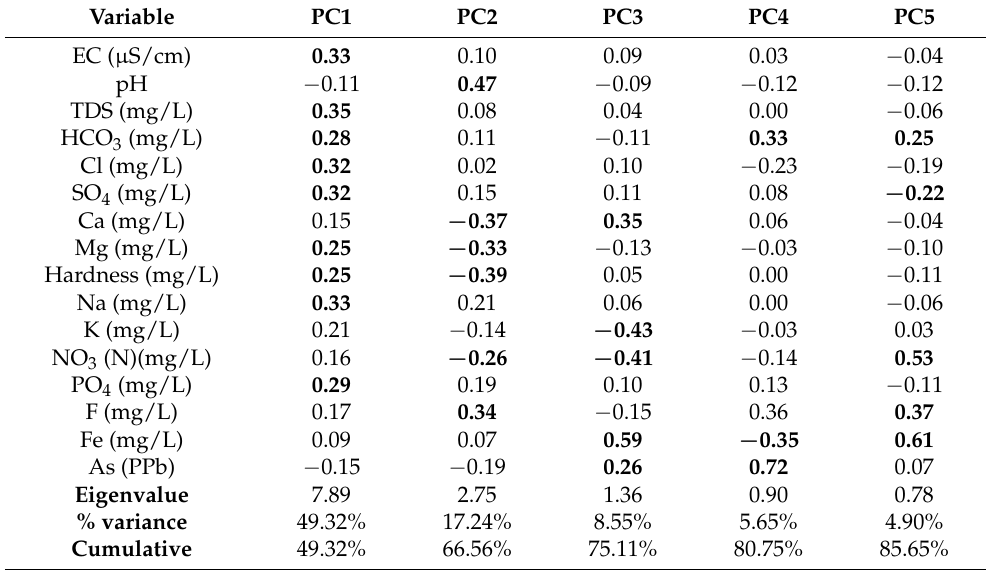
Table 3. PCA for arsenic along with other chemical variables present in the groundwater of the study